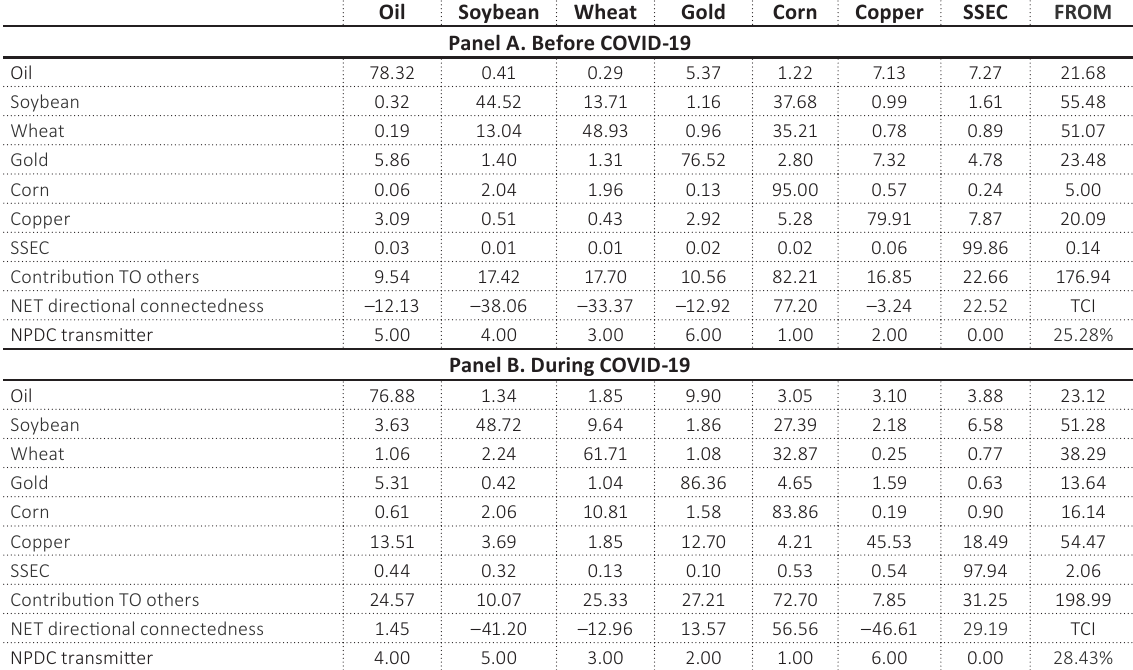
Table 2. DCC-GARCH connectedness